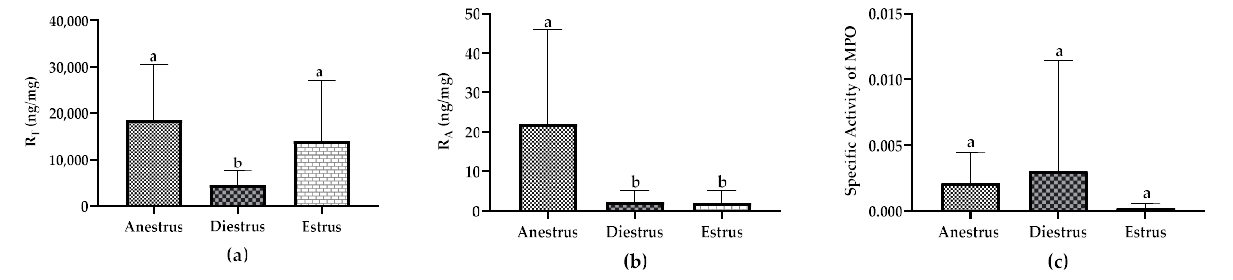
Figure 2. Myeloperoxidase (MPO) in uterine fluid of mares in anestrus, diestrus and estrus in ab- sence of inflammation: ( a ) Total MPO/total protein ratio (R T ), ( b ) Active MPO/total protein ratio (R A ), ( c ) Specific Activity of MPO (active MPO/total MPO). Data are displayed as raw data (mean with SD). Columns with a different superscript are statistically different ( p < 0.05).